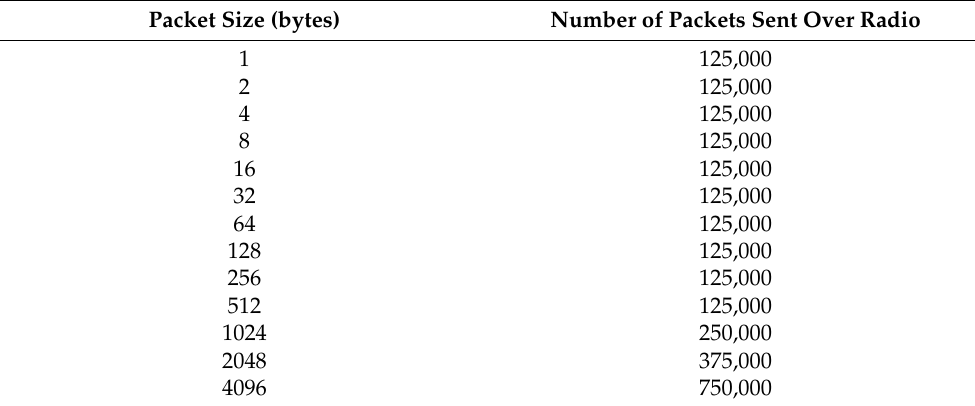
Table 1. WIC UWB GW (CDHU) to WIC UWB node (PDHU) average end-to-end delay.